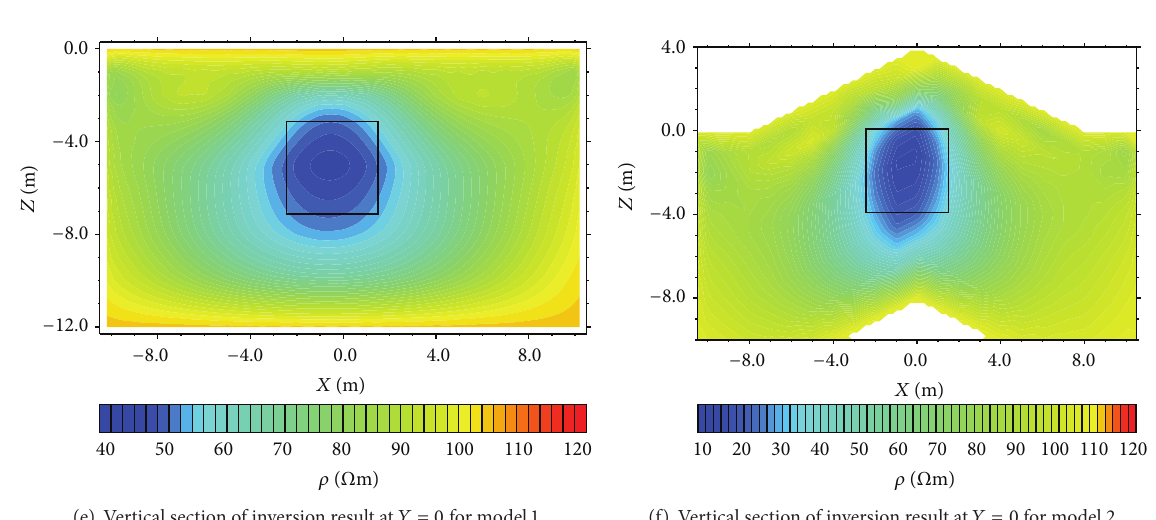
Figure 6: A comparison of inversion result for the model without and with